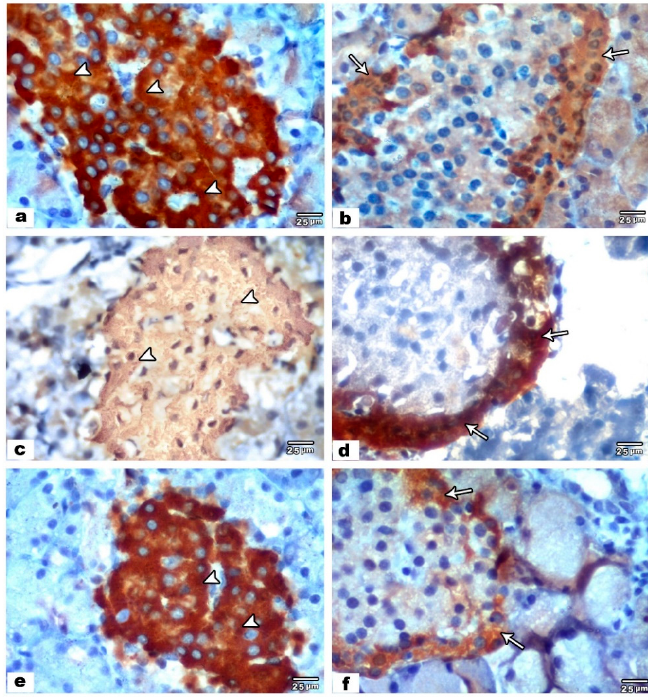
Figure 2. Photomicrographs of immunohistochemically stained pancreatic sections. Control sections ( a , b ). ( a ) An anti-insulin immune-reactivity of pancreatic islet showing brown-stained pancreatic β cells with strong positive immune-reaction (arrowheads). ( b ) An anti-glucagon immune-reactivity of pancreatic islet showing brown-stained pancreatic α cells with mild positive immune-reaction (arrow). VPA treated pancreatic sections ( c , d ). ( c ) An anti-insulin immune-reactivity of pancreatic islet showing brown-stained pancreatic β cells with mild positive immune-reaction (arrowheads). ( d ) An anti-glucagon immune-reactivity of pancreatic islet showing brown-stained pancreatic α cells with strong positive immune-reaction (arrow). VPA and ALA treated pancreatic sections ( e , f ). ( e ) An anti-insulin immune-reactivity of pancreatic islet showing brown-stained pancreatic β cells with strong positive immune-reaction (arrowheads). ( f ) An anti-glucagon immune-reactivity of pancreatic islet showing brown-stained pancreatic α -cells with mild positive immune-reaction (arrow). Biology 2020 , 9 , x